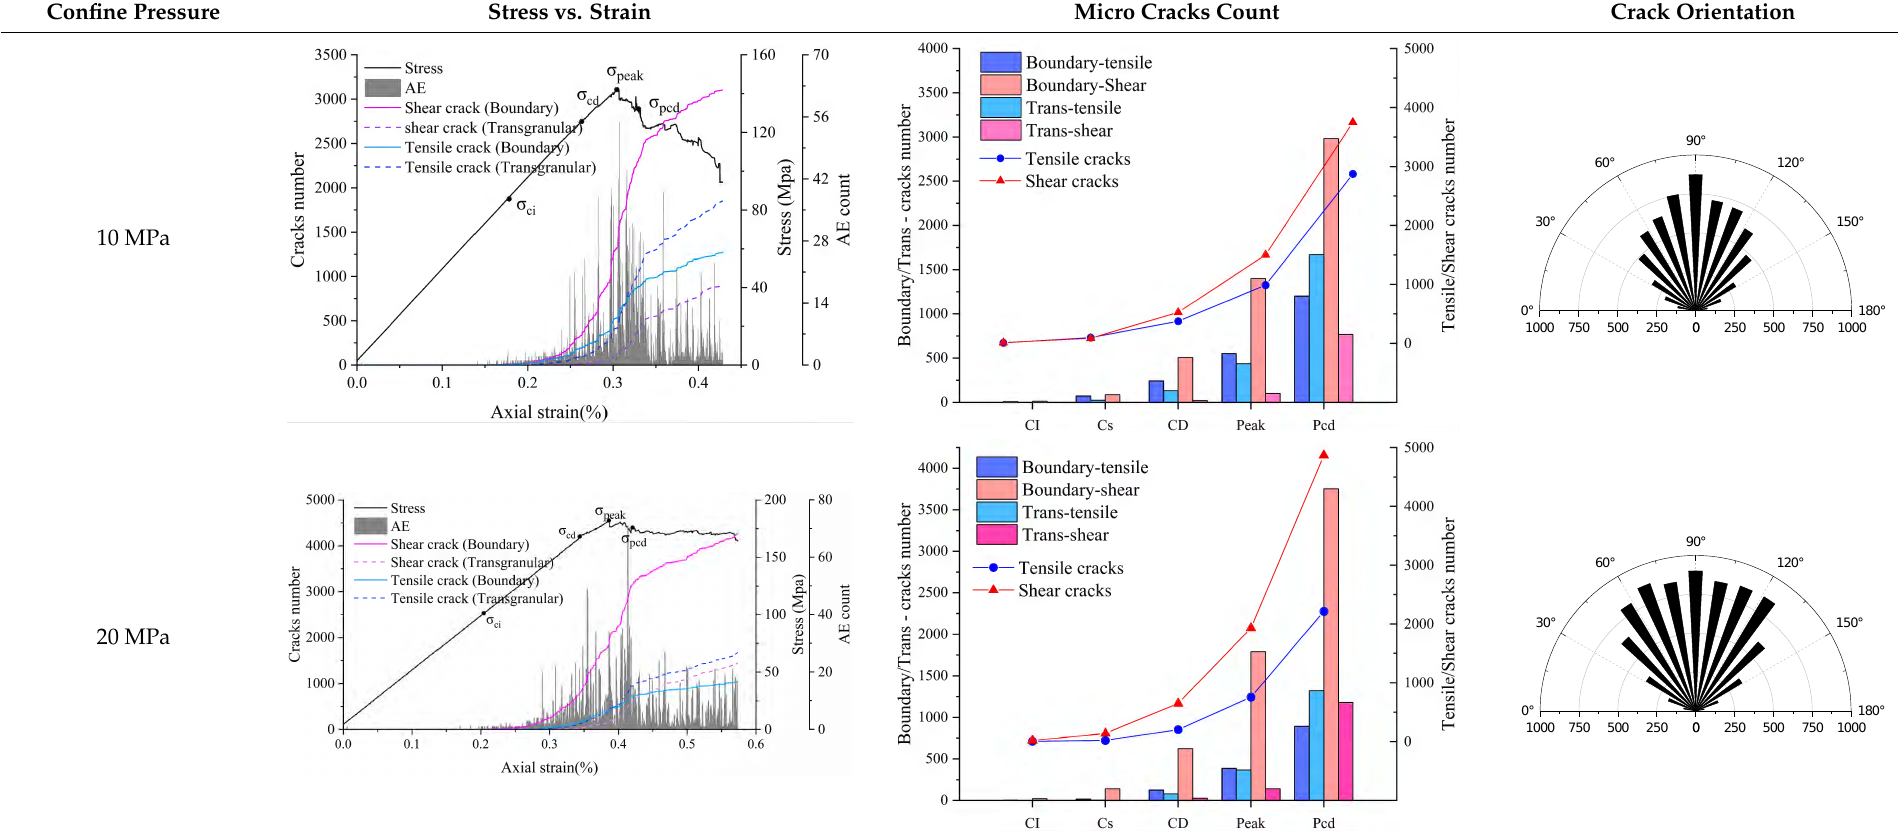
Table 1. This is a table caption. Tables should be placed in the main text near to the first time they are